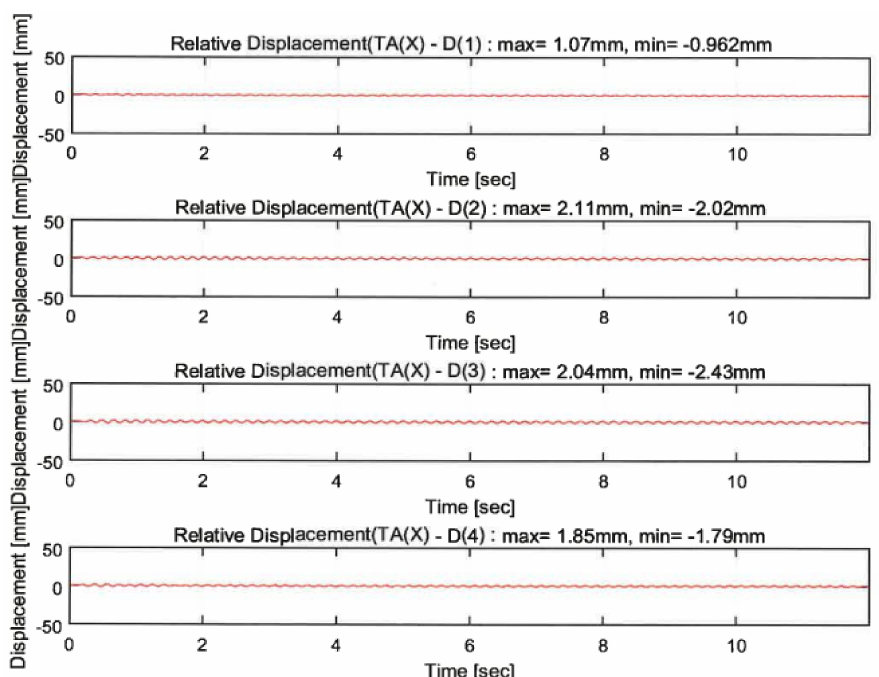
Figure 13. Dynamic responses under a sinusoidal wave of 4.5 Hz.